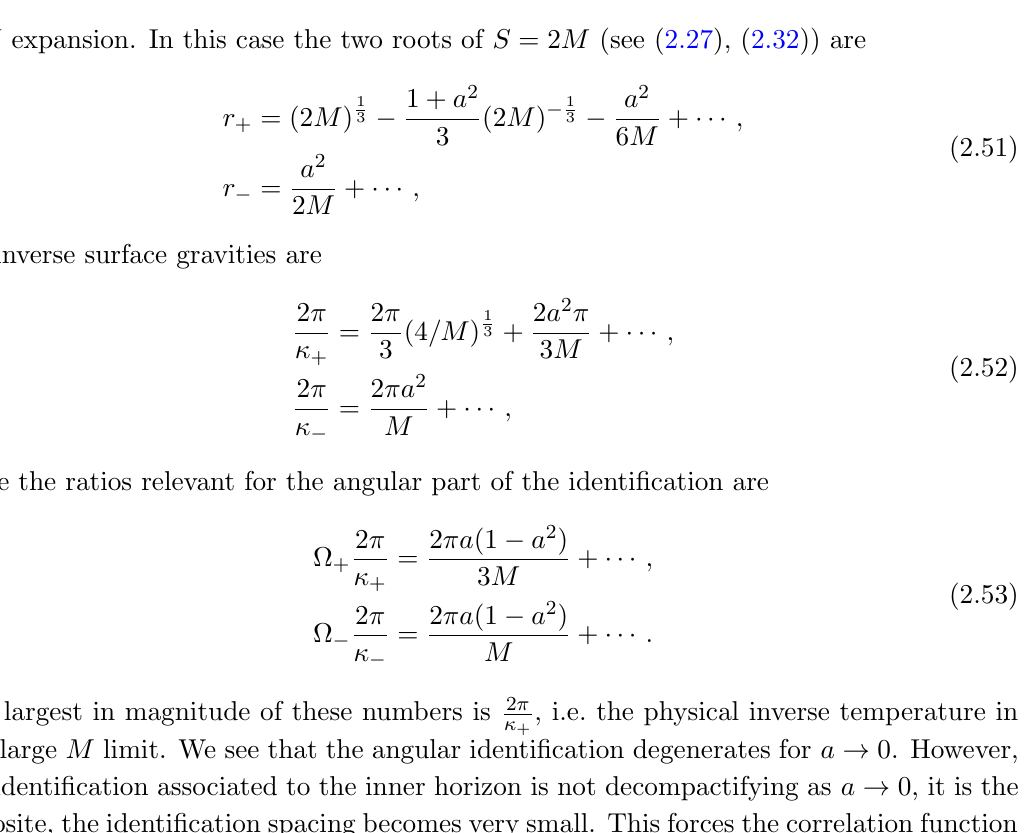
Figure 4 . Left: analytic structure of the two point function imposed by unitarity and causality. The function is analytic in the strip, has light cone singularities at the red points, which are also branch points, and periodically extended using the KMS relation. Right: the inner KMS condition would give rise to a copy of the light cone singularity inside the region where the function must be